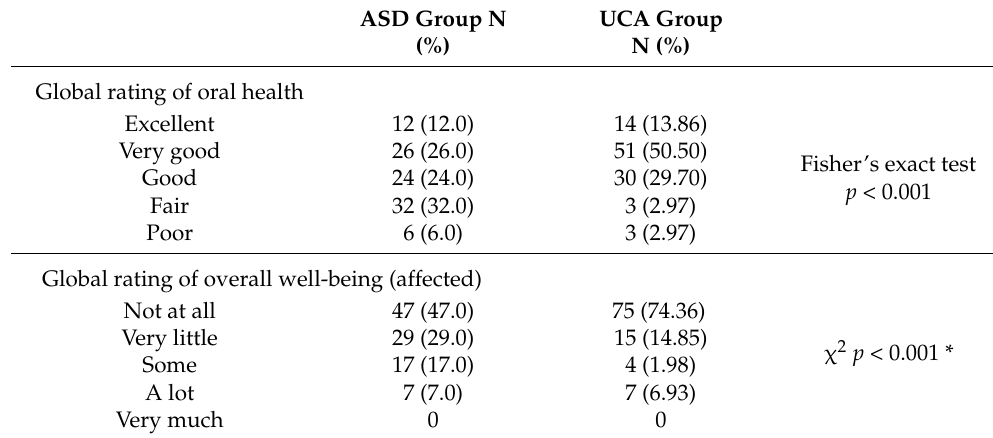
Table 3. Distribution of responses to the global perception questions.